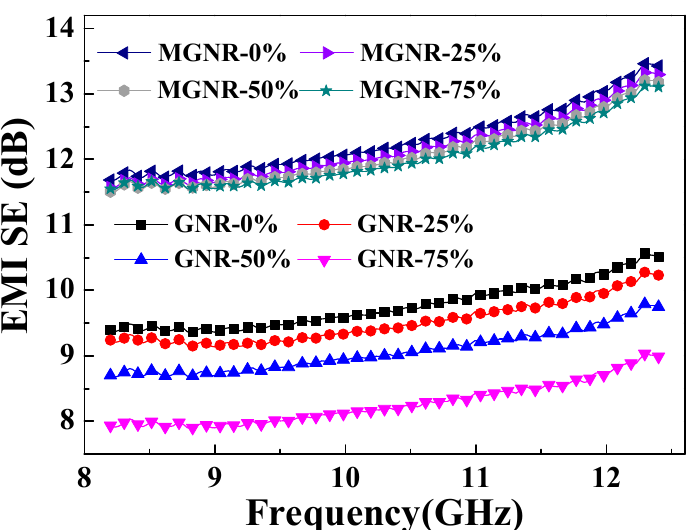
Figure 4. EMI SE of the MGNR-6 and GNR-6 composites which were treated for permanent deformation with different strain (the thickness was 0.6 mm).